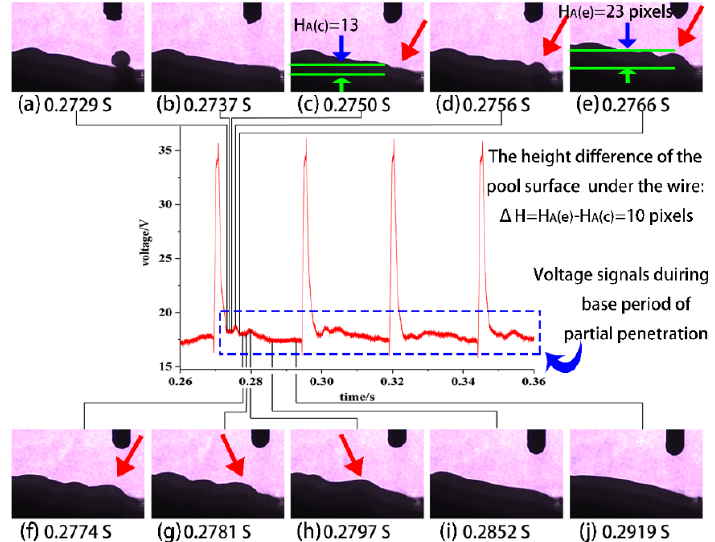
Figure 5. Combination of voltage signal waveform and partly penetrated weld pool oscillation process: High-speed photographs of weld pool at di ff erent times:( a )–( j ) (welding travel speed: 24.75 cm/min).